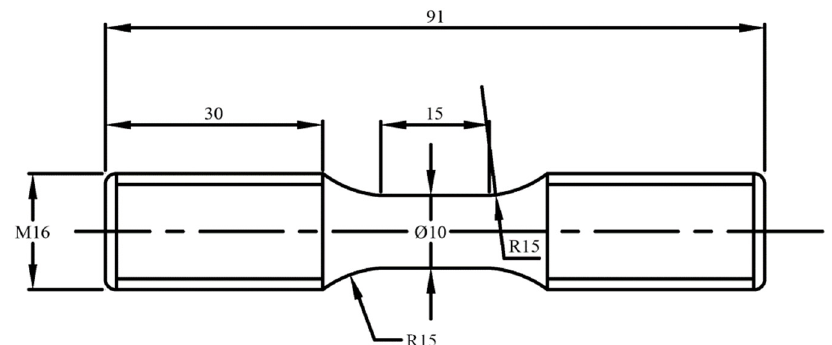
Figure 6. Dimensions of the ratcheting test specimens (units: mm).